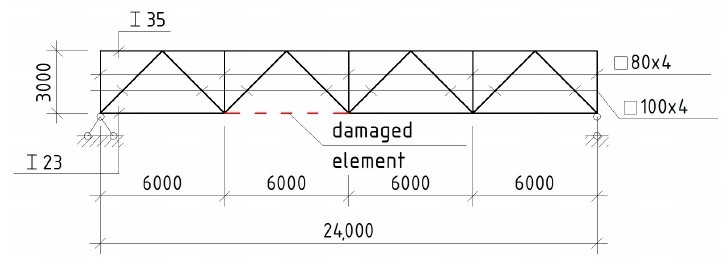
Figure 13. Truss with a damaged lower chord.